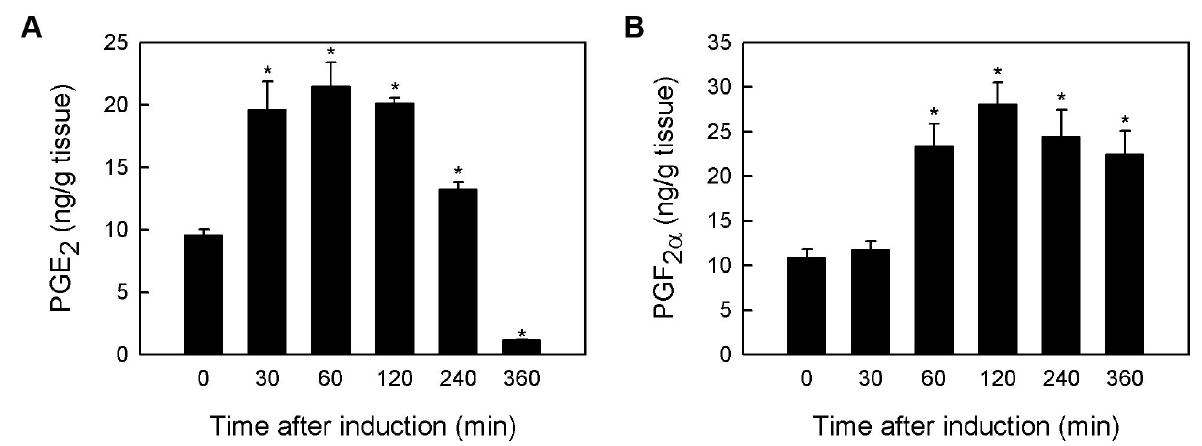
Figure 6. In vitro prostaglandin synthase activity assay using shrimp ovary homogenates. Shrimp ovary homogenates were incubated with 25 µM AA at 28 °C and collected at different time points (0, 30, 60, 120, 240 and 360 min). The homogenates were spun down and concentrations of PGE (A) and PGF (B) in the homogenate supernatant were estimated using EIA. The 2 2α experiment was performed in triplicate and error bars indicate the standard deviation from the means. Asterisk indicates significant difference between the prostaglandin concentration at 0 h and the marked time point ( P <0.05).